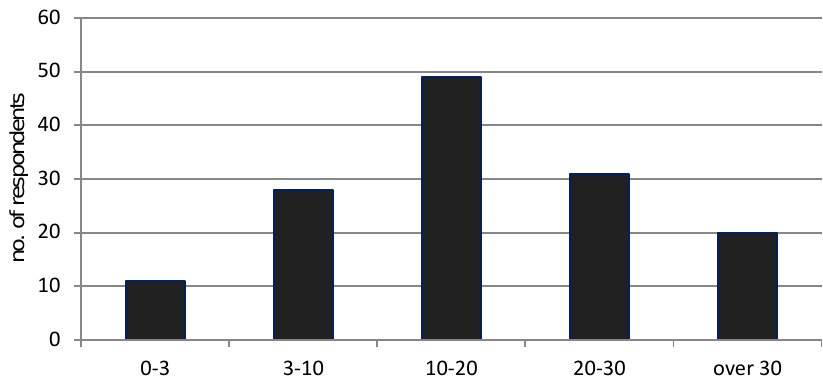
Figure 3: The structure of the sample used for the survey by years of experience in work Source: own